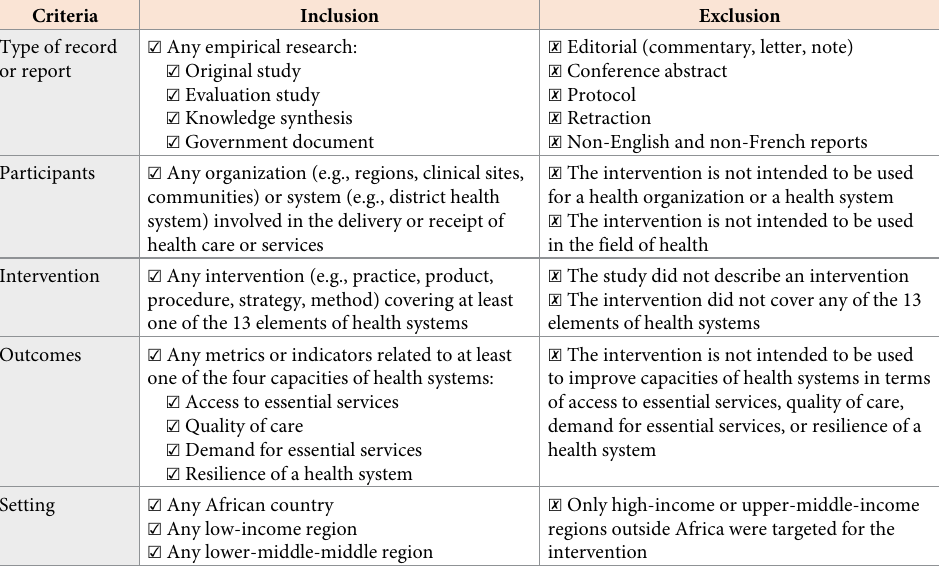
Table 1. Criteria for considering records or reports for this